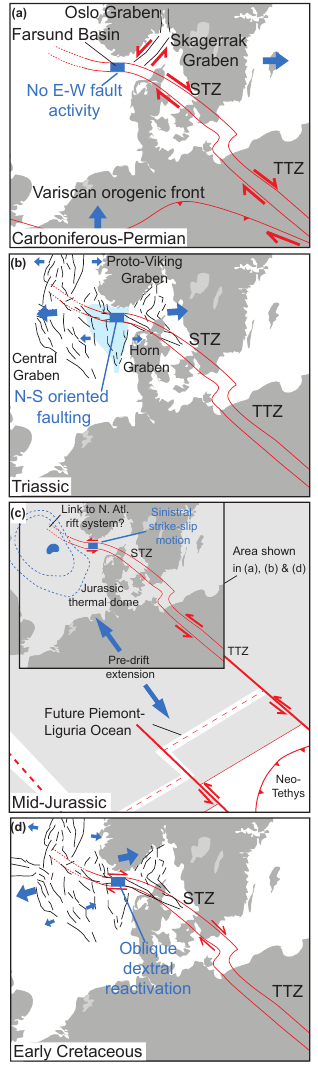
Figure 16. (a) Schematic model showing the regional tectonic set- ting during the Carboniferous–Permian and linking this to the lack of observed activity within the Farsund Basin. (b) Schematic model linking the regional Triassic E–W-oriented extension to the Trias- sic N–S-oriented faulting within the Farsund Basin. (c) Wider-scale schematic model to highlight potential causative mechanisms for Early–Middle Jurassic sinistral strike-slip activity in the Farsund Basin. Viable driving mechanisms include the uplift of the middle North Sea thermal dome and the opening of the Piemont–Liguria Ocean. (d) Schematic model linking the local Early Cretaceous dex- tral transtension observed within the Farsund Basin to regional E–W to NE-SE extension occurring at this